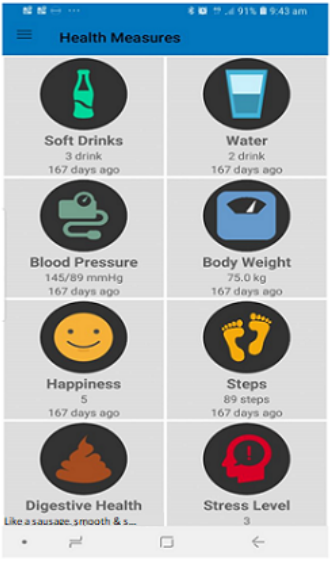
Figure 3. Health measures screen for iPhone.